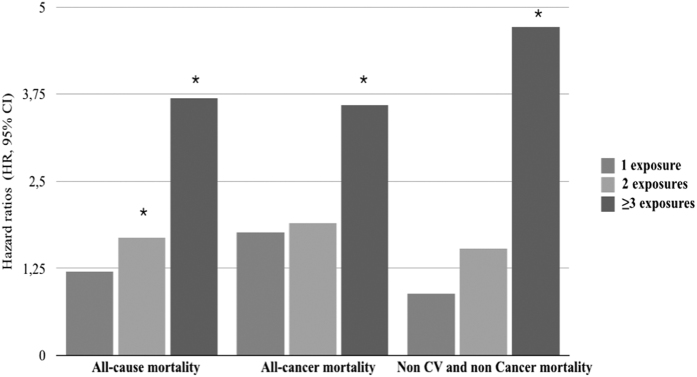
Histogram representing Hazard Ratios (HR, 95% CI) for all-cause, all-cancer, and non CV and non cancer mortality depending on cumulative dental exposure (dental plaque, dental calculus, gingival inflammation, functional Masticatory Units <5 and missing teeth >10) (Propensity score model).